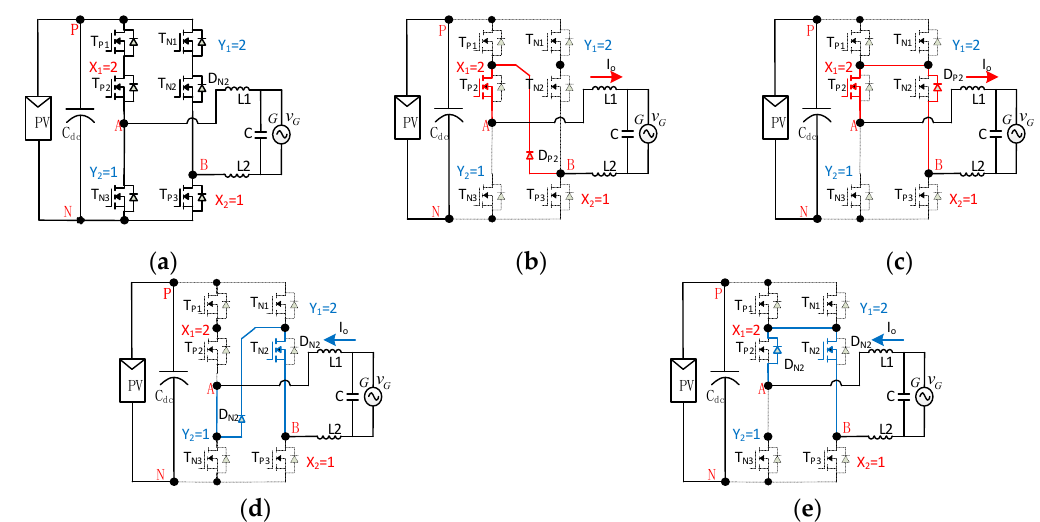
Figure 12. Four modes under X 1 = 2, X 2 = 1, Y 1 = 2, and Y 2 = 1. ( a ) PC and NC modes; ( b ) PF mode #1; ( c ) PF mode #2; ( d ) NF mode #1; ( e ) NF mode #2.